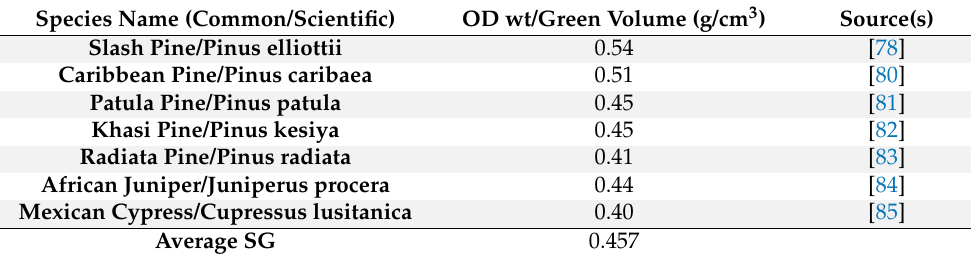
Table A1. Raw data of the softwood tree species for the basic density